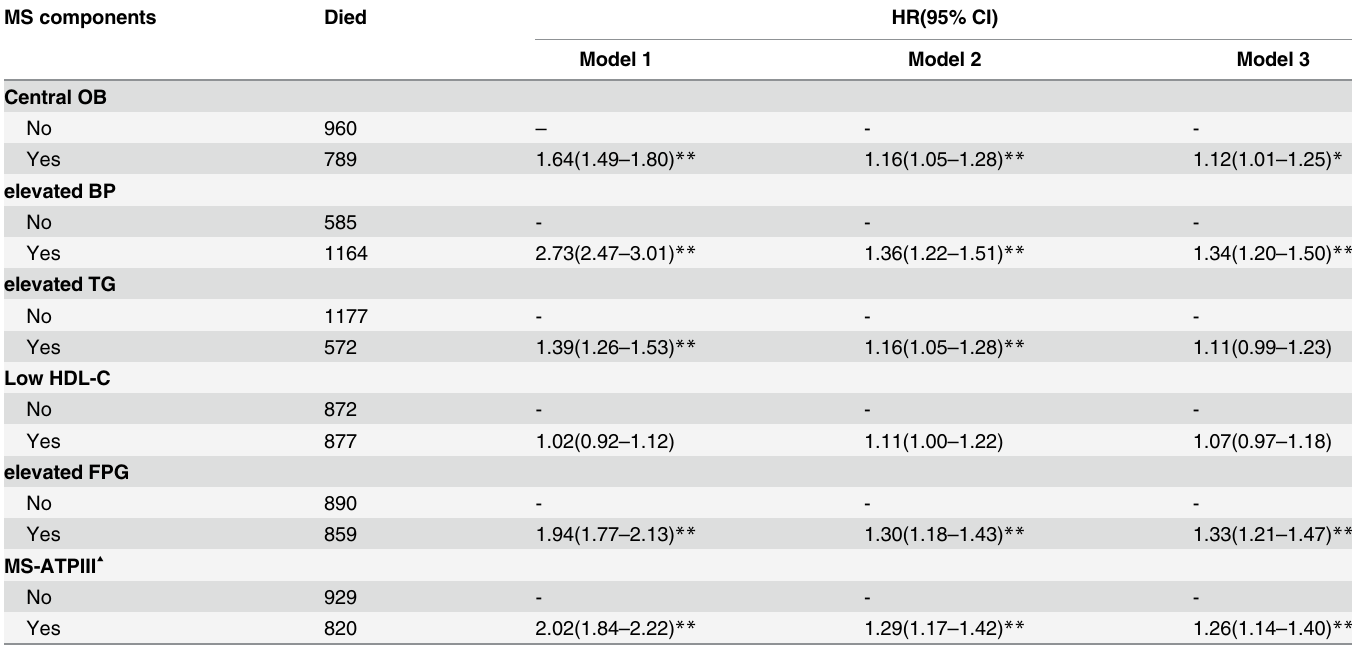
Table 4. All-cause mortality associated with MS and its individual